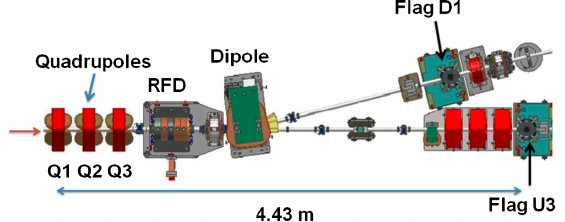
FIG. 1. Layout of the SPARC_LAB diagnostic section beam line. The beam is coming from the left side. The drawing is not to